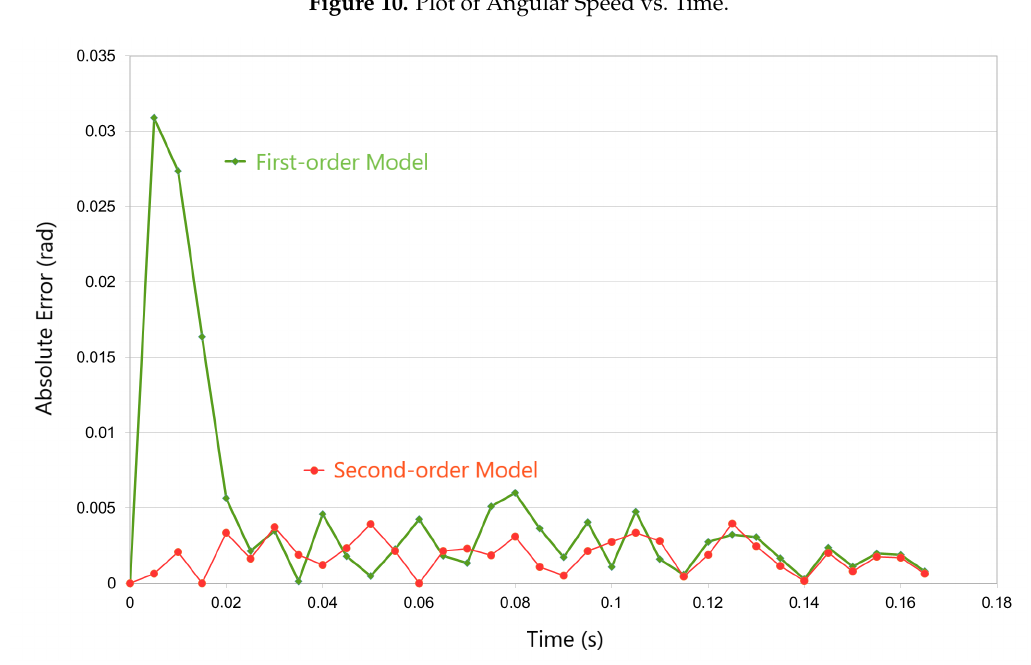
Figure 11. Absolute Error vs.